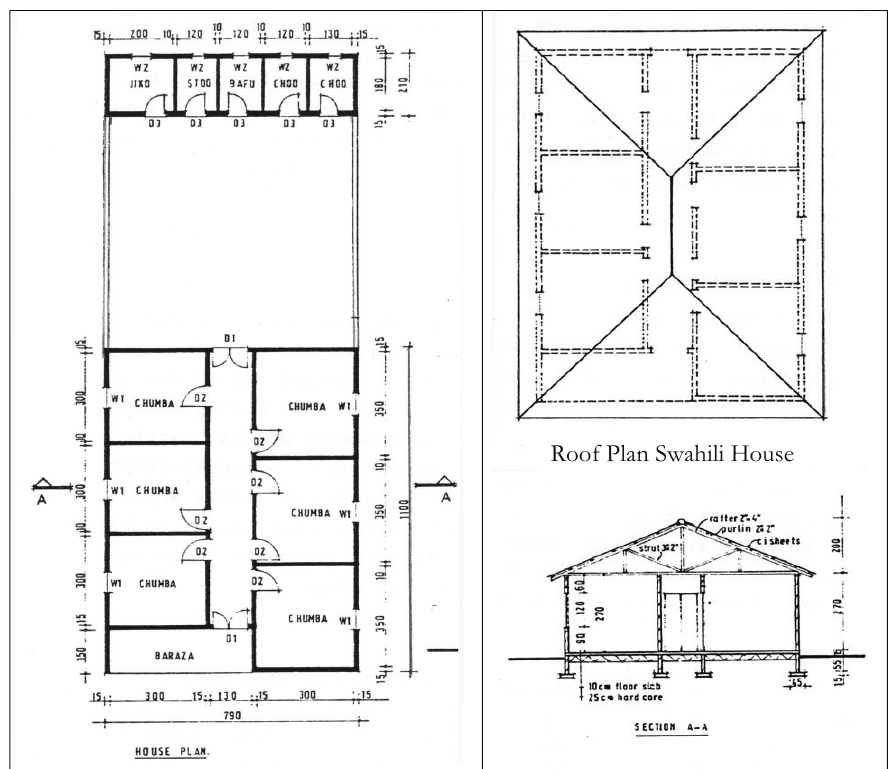
Figure 2. A plan of the modern Swahili house. Source: Nnkya (1984, p. 79). the veranda. The courtyard, meanwhile, offers enclosure and privacy; it is where everyday activities such as laun‐ dering, cooking, resting, and playing take place (Figure 4).